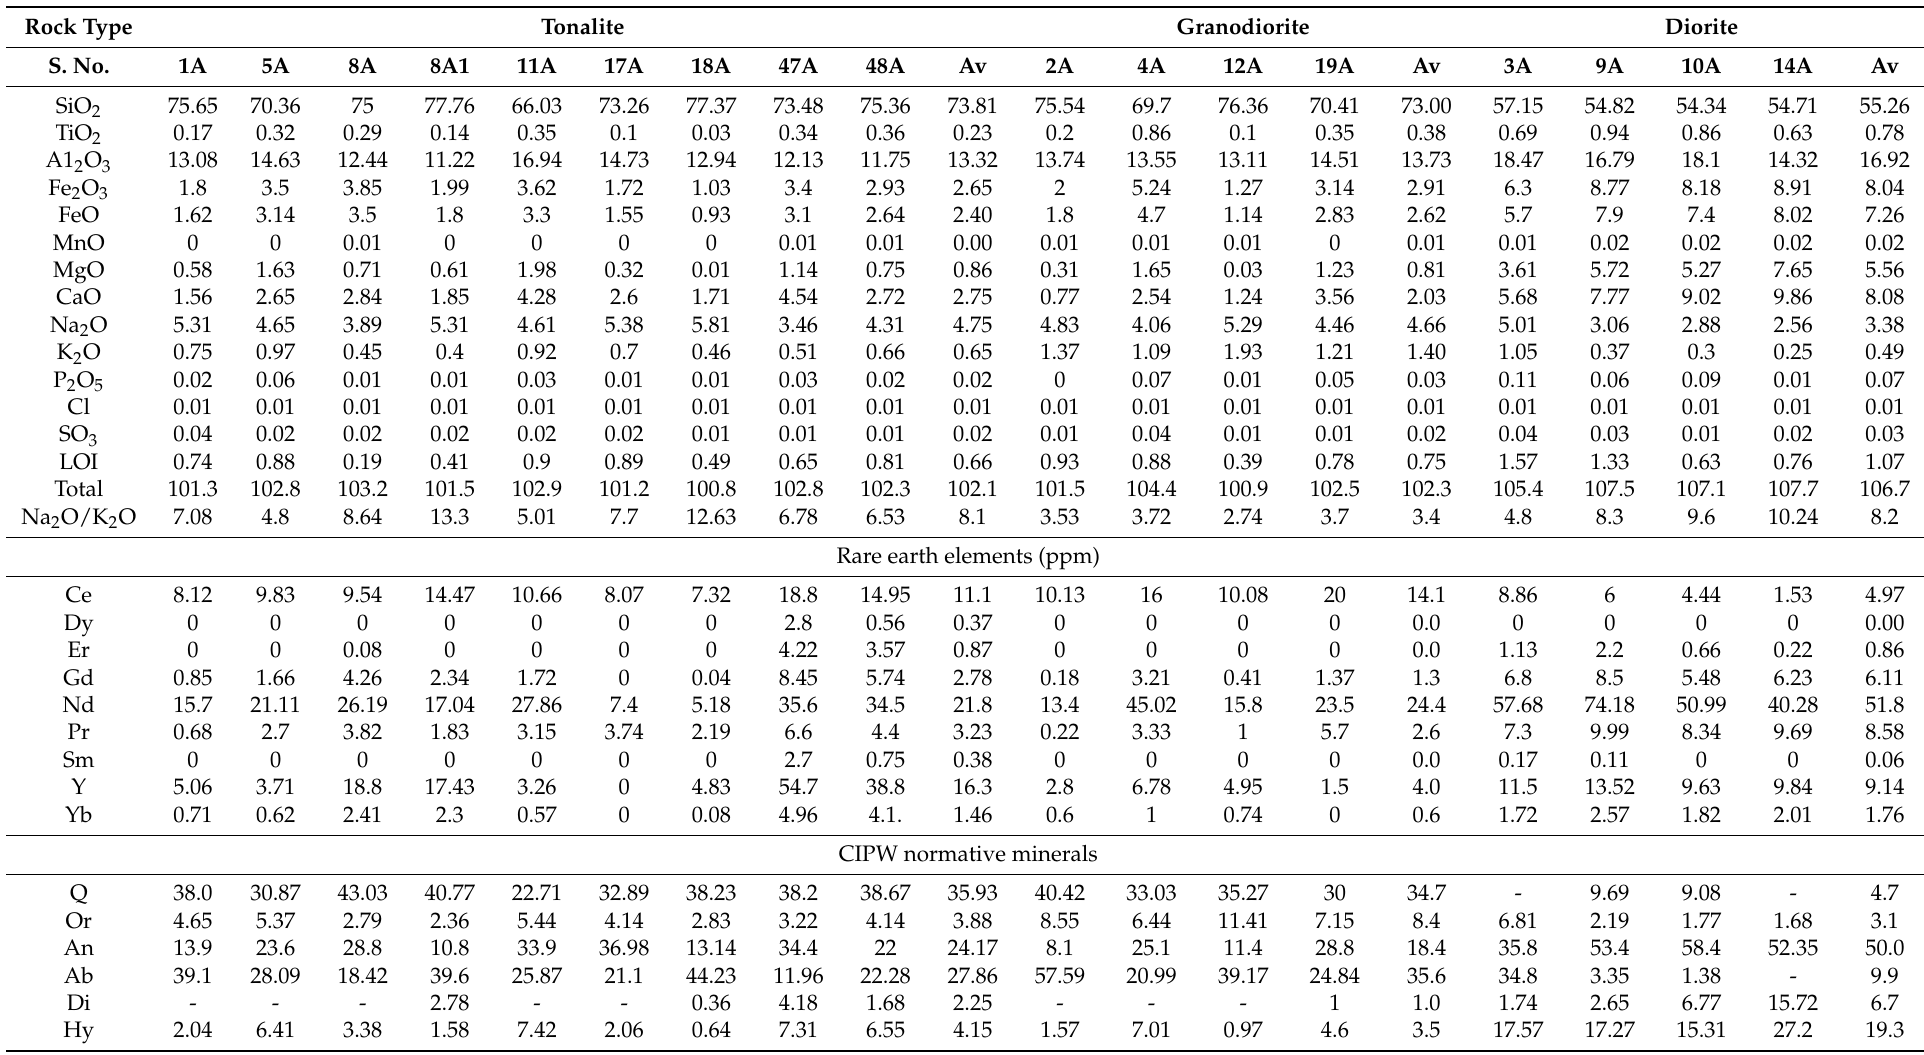
Table 6. Major oxides (wt.%), trace elements (ppm), some elemental ratios, and CIPW norm of the studied tonalite, granodiorite, and diorite